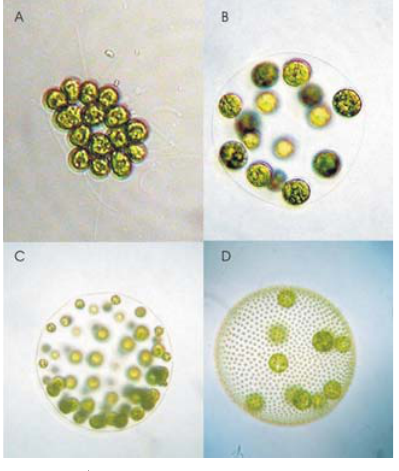
Figure 4. Four Different Species of Volvocales Algae (A) Gonium pectorale , (B) Eudorina elegans , (C) Pleodorina californica , and (D) Volvox carteri . These are unicellular organisms that live in colonies and have both large and small gametes. Photo courtesy of Aurora M. Nedelcu, from the Volvocales Information Project (http:⁄⁄www.unbf. ca/vip/index.htm).